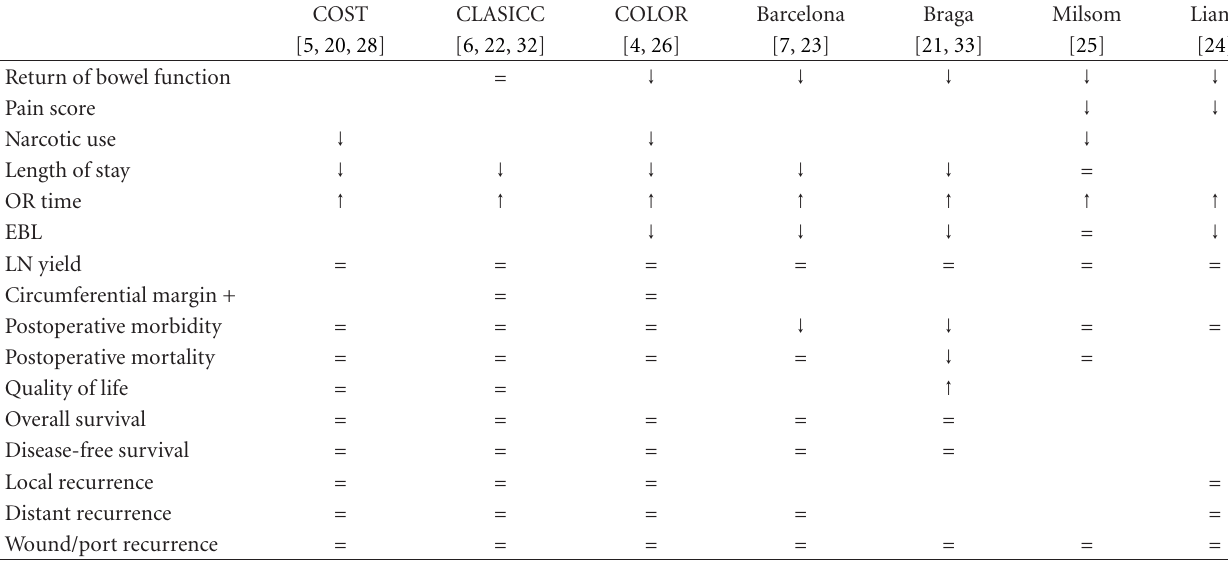
Table 1: Short-term and long-term outcomes of large-scale randomized controlled trials for laparoscopic colectomy compared to open colectomy for colon